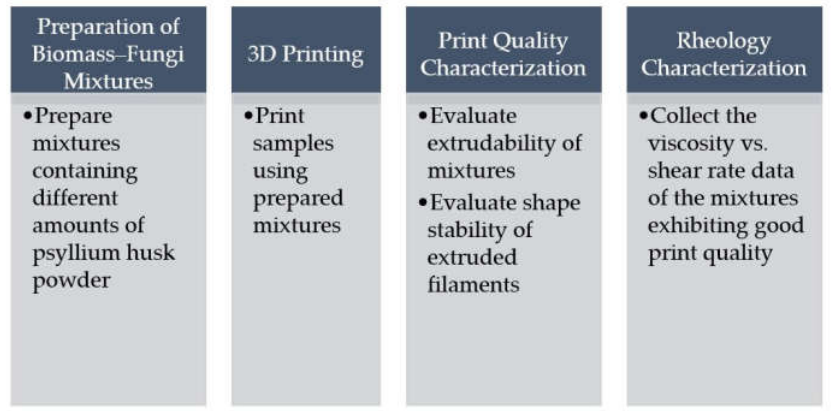
Figure 2. Experimental procedure.